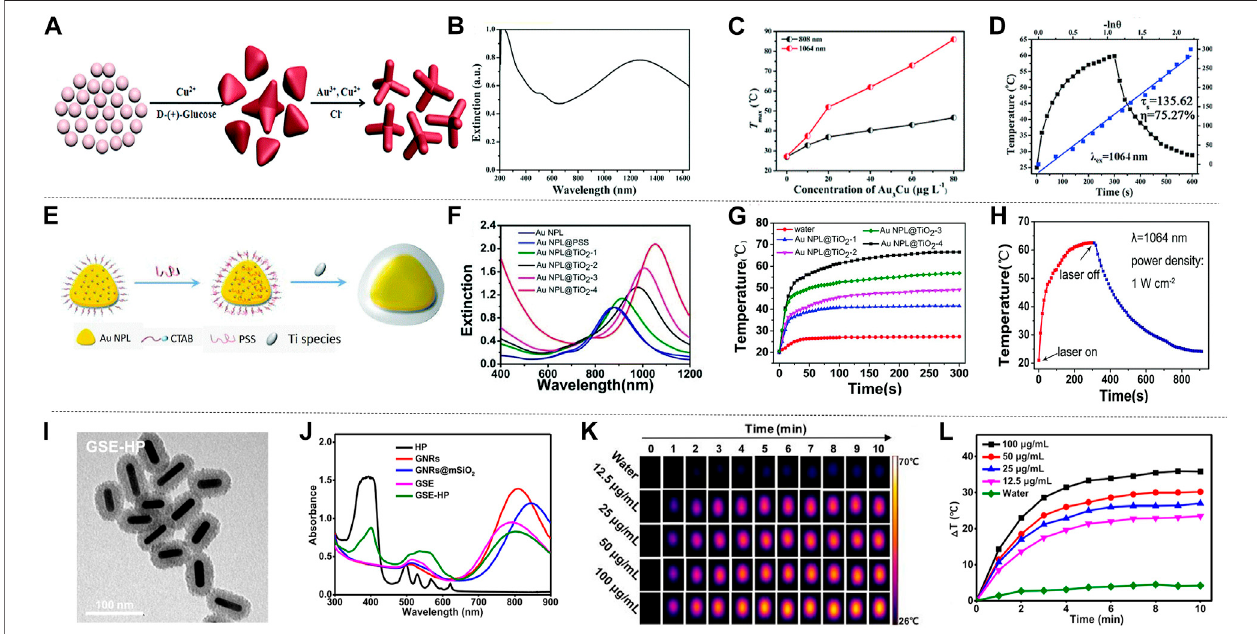
FIGURE 2 | The photothermal properties of Au nanomaterials. (A) Numerical control growth of tetrapods. (B) Ultraviolet-visible-NIR (UV-vis-NIR) extinction spectrum of TPNCs. (C) The relationship between the concentration of TPNCs after irradiating Au 3 Cu@PEG TPNC with 808 and 1,064 nm laser for 5 min. (D) The photothermal conversion ef fi ciency of Au 3 Cu@PEG TPNCs under 1,064 nm laser irradiation, the blue line is the heat transfer time constant of the system determined by linear time data during cooling (reproduced from (Wang, at al., 2018) with permission from Royal Society of Chemistry). (E) Schematic diagram of the synthesis of AuNPL@TiO 2 . (F) Extinction spectra of conventional gold nanoplate samples and gold nanoplate samples coated with different thickness shells. (G) The temperature changes of AuNPL@TiO 2 with different thicknesses of shell layer within 5 min of irradiation with a laser with an intensity of 1,064 nm (1 W cm − 2 ), in which water is the blank control group. (H) Schematic diagram of the photothermal effect of AuNPL@TiO 2 -4 with a shell thickness of 68 nm irradiated with a 1,064 nm laser (reproduced from(Gaoetal.,2019)withpermissionfromRoyalSocietyofChemistry). (I) TransmissionelectronmicroscopeimageofGSE-HP. (J) AbsorptionspectraofGSE-HPand contrast materials. (K) Thermal image of GSE-HP. (L) Use 808 nm laser with a power density of 0.8 W cm − 2 to irradiate GSE-HP with different concentrations, and the corresponding heating curve (reproduced from (Luo et al., 2020) with permission from American Chemical Society).